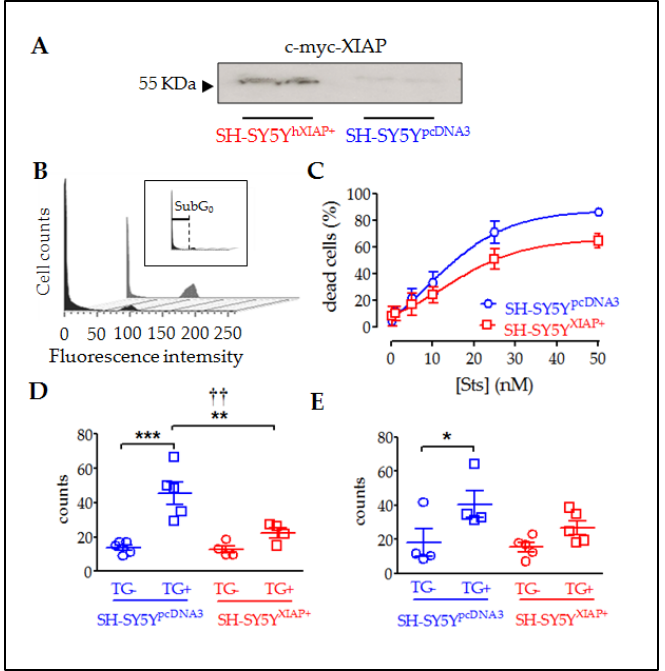
Figure 6. Reduction in cell death in SH-SY5Y cultures overexpressing XIAP. ( A ) Immunoblot showing the overexpression of c-myc-XIAP fusion protein in homogenates obtained from SH-SY5Y pcDNA3 and SH-SY5Y XIAP+ cells. ( B ) Representative flow cytometry histograms of DAPI-stained SH-SY5Y cell cycle under Sts stimulation. The black profile corresponds to SH-SY5Y WT -treated control cultures and the grey profile to SH-SY5Y XIAP+ -treated cells. Insert in B shows the sub-Go region (apoptotic cells with condensed nuclei) of the cell cycle used to evaluate the percentage of cell death in the population. ( C ) Dose–response of the percentages of apoptotic cells in the SH-SY5Y WT (blue symbols) and SH-SY5Y XIAP+ (red symbols) cell cultures after treatment with increasing concentrations of Sts (symbols represent the mean ± SEM and lines the Michaelis–Menten non-linear fit of the data; ** = p -value < 0.01 in paired Student’s t -test; † = p -value < 0.05 in two-way ANOVA of genetic background effect). Early apoptotic death was measured through annexin V staining ( D ) and late cell death was measured by DAPI staining ( E ) after TG treatment in SH-SY5Y pcDNA3 (blue symbols) and SH-SY5Y XIAP+ (red symbols) cell cultures (dot plots represent mean ± SEM; *** = p- value < 0.001, ** = p- value < 0.01, and * = p- value < 0.05 in non-paired Student ’ s t- test. †† = p- value = 0.01 in two-way ANOVA of genetic background effect; n = 4-5 independent experiments).